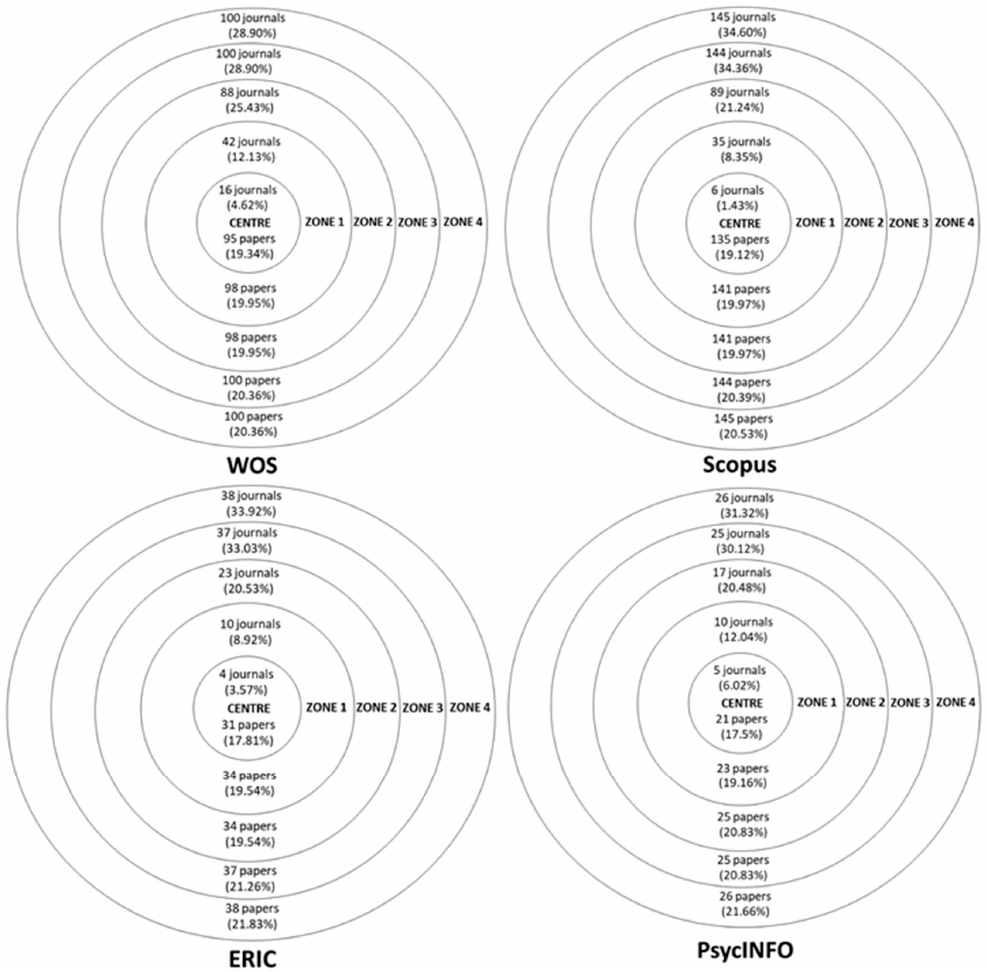
Figure 2. Bradford’s scattering zone of scientific journals on Big Data in education.